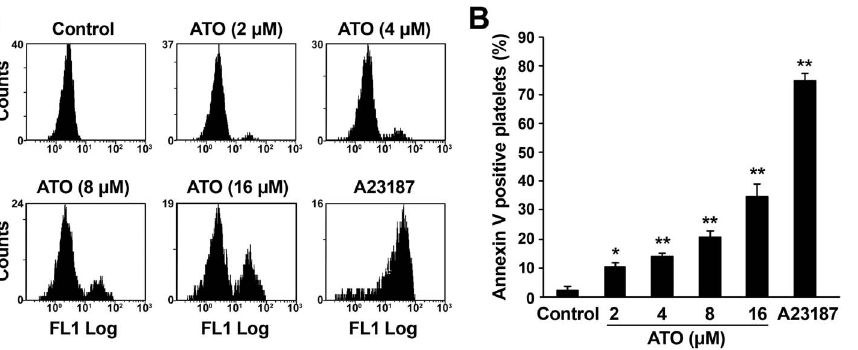
Figure 3. ATO dose-dependently induces PS exposure in platelets. Platelets were pre-treated with 2, 4, 8, 16 m M of ATO or vehicle at 37 u C for 5 hrs. (A) Annexin V binding buffer was mixed with the pre-treated platelets and FITC-annexin V at a ratio of 50: 10: 1. The samples were gently mixed and incubated at RT for 15 min in the dark, then analyzed by flow cytometry. (B) Quantitation data from 3 separate experiments with different donors are illustrated (mean 6 SD). ** P , 0.01, * P , 0.05 compared with vehicle controls.